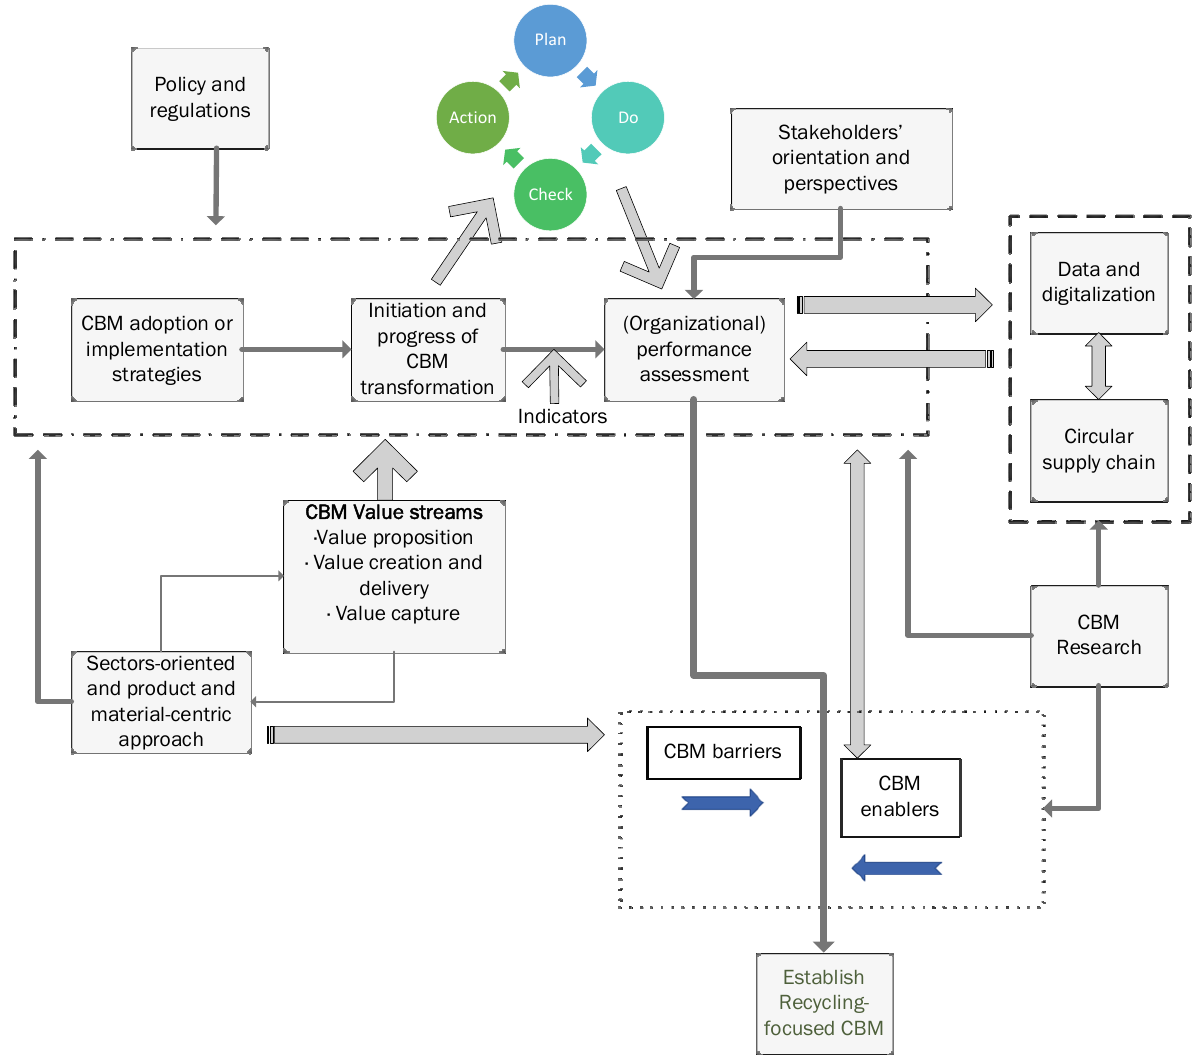
Figure 7. Conceptual framework towards developing recycling focused CBM.